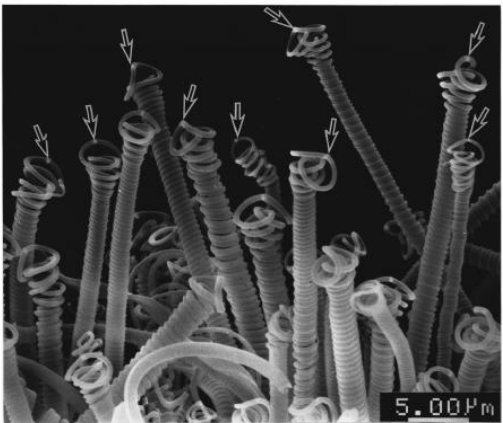
Figure 4. Representative carbon coils growing vertically on the substrate ([7], Motojima and Chen,